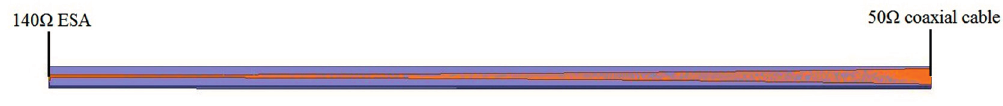
Figure 2. Structure of the exponential asymptote microstrip balun.